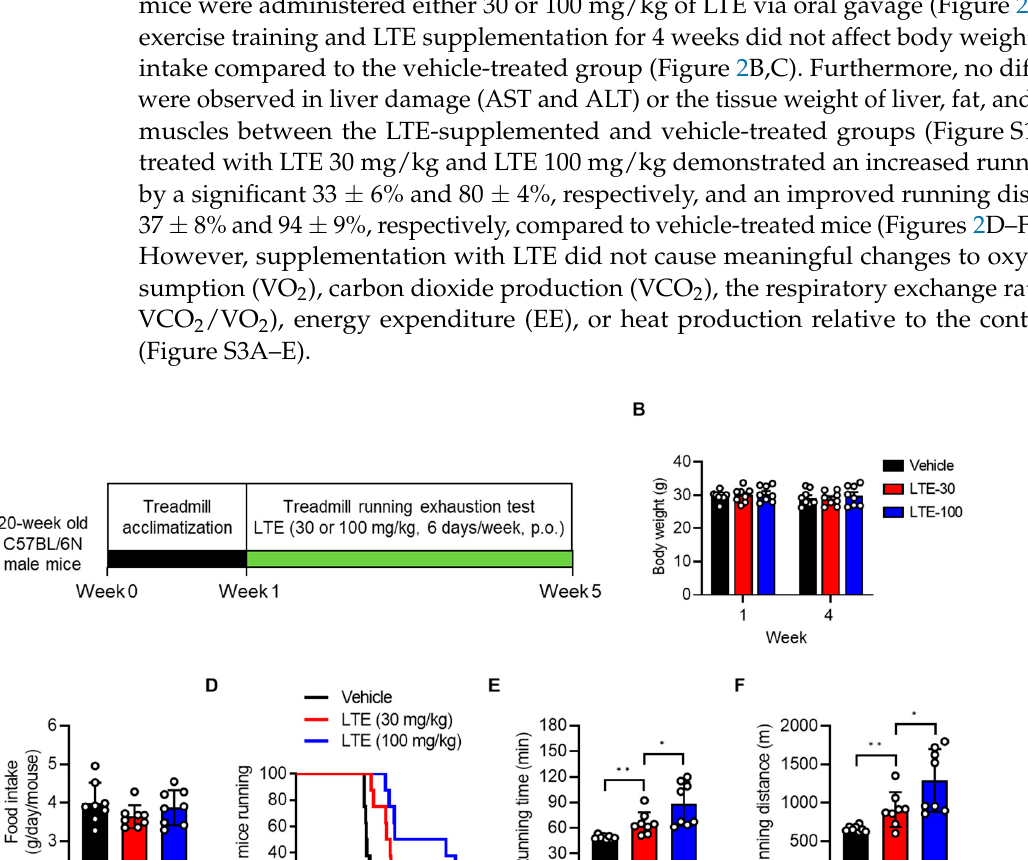
Figure 2. Effects of LTE supplementation on treadmill running endurance. ( A ) Schematic of experimental design to assess the effect of LTE on exercise performance. ( B , C ) Body weight change after the 4-week exercise and LTE supplementation program, and daily food intake of mice ( n = 8). ( D ) Running population plotted against time to exhaustion (10 min at 10 m/min with an increase in running speed by 2 m/min every 10 min to a maximum of 16 m/min). Total running time until exhaustion was determined ( n = 8). ( E , F ) Average running time and running distance until exhaustion under a forced running exercise-to-exhaustion test using data acquired during the last two weeks of testing ( n = 8). Values are mean ± S.E.M., * p < 0.05 and ** p < 0.01. LTE-30, LTE 30 mg/kg p.o.; LTE-100, LTE 100 mg/kg p.o.